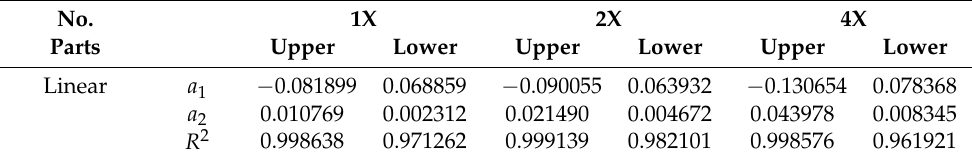
Table 5. The fitting parameters of the deformation of the three PGM simulations.